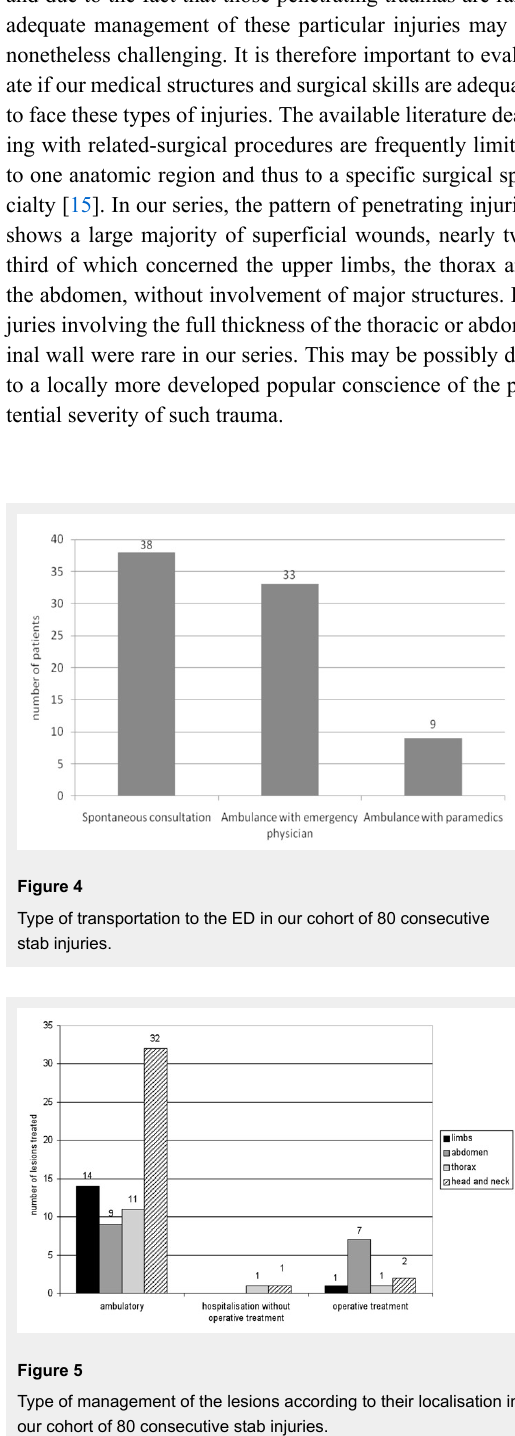
Type of management of the lesions according to their localisation in our cohort of 80 consecutive stab